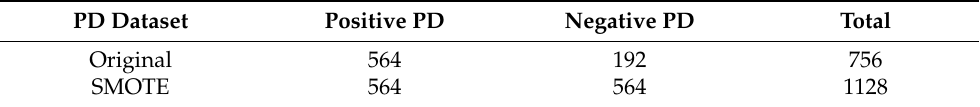
Table 2. Comparative between patients and non-patients